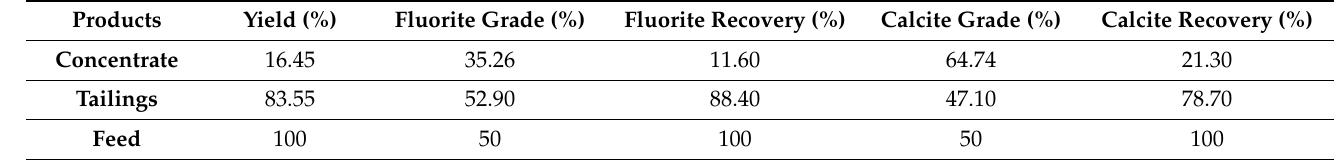
Table 1. Microflotation results for artificial mixed ore before NaF pretreatment.